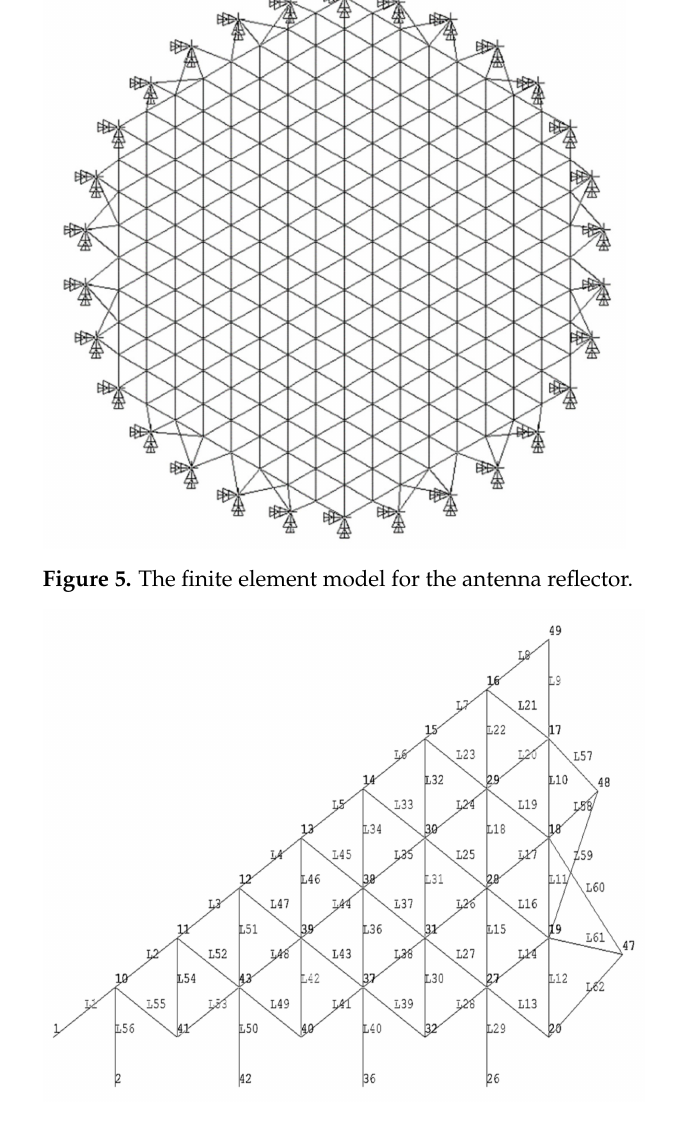
Figure 6. The unique cable